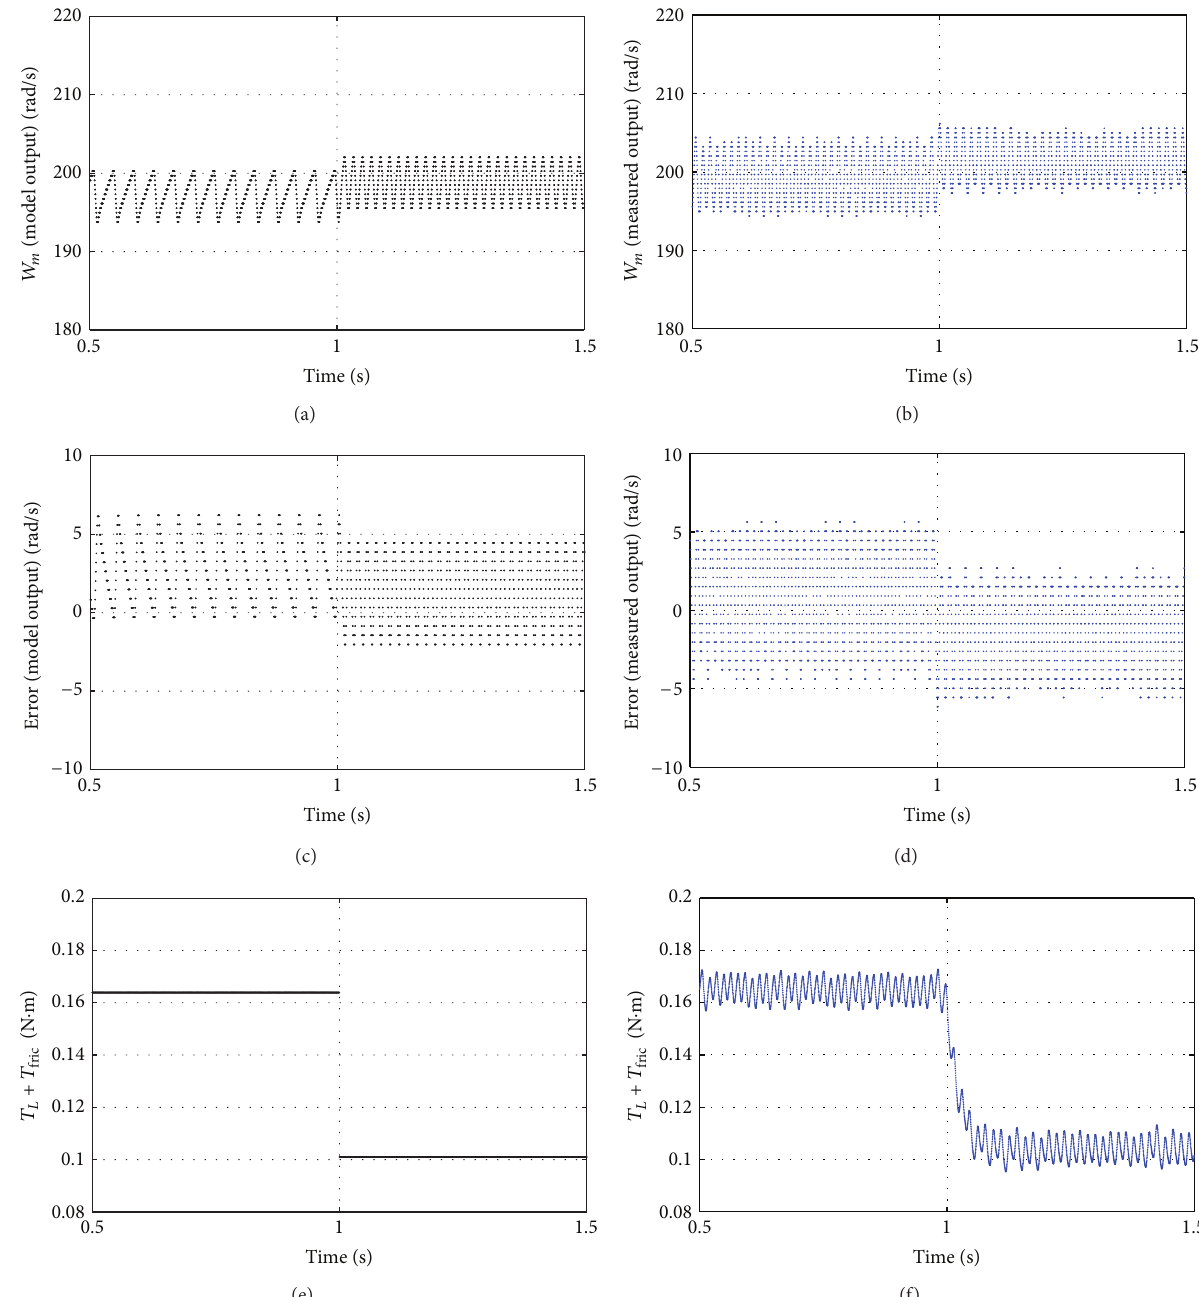
Figure 6: Simulated and experimental results when the load torque 𝑇 𝐿 + 𝑇 simulated results. (b), (d), (f) experimental